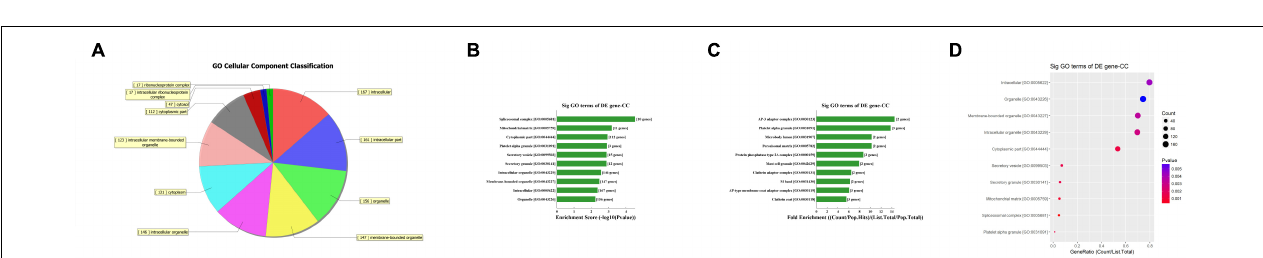
FIGURE 5 | The GO annotations for biological process of target mRNAs regulated by the five candidate circRNAs. (A) The pie chart above shows the top 10 counts of the significant enrichment terms. (B) The bar plot shows the top 10 enrichment score values of the significant enrichment terms. (C) The bar plot shows the top 10-fold enrichment values of the significant enrichment terms. (D) The dot plot shows the gene ratio values of the top 10 most significant enrichment terms. Gene ratio: the GOID’s gene ratio value, which equals (Count/List.Total).